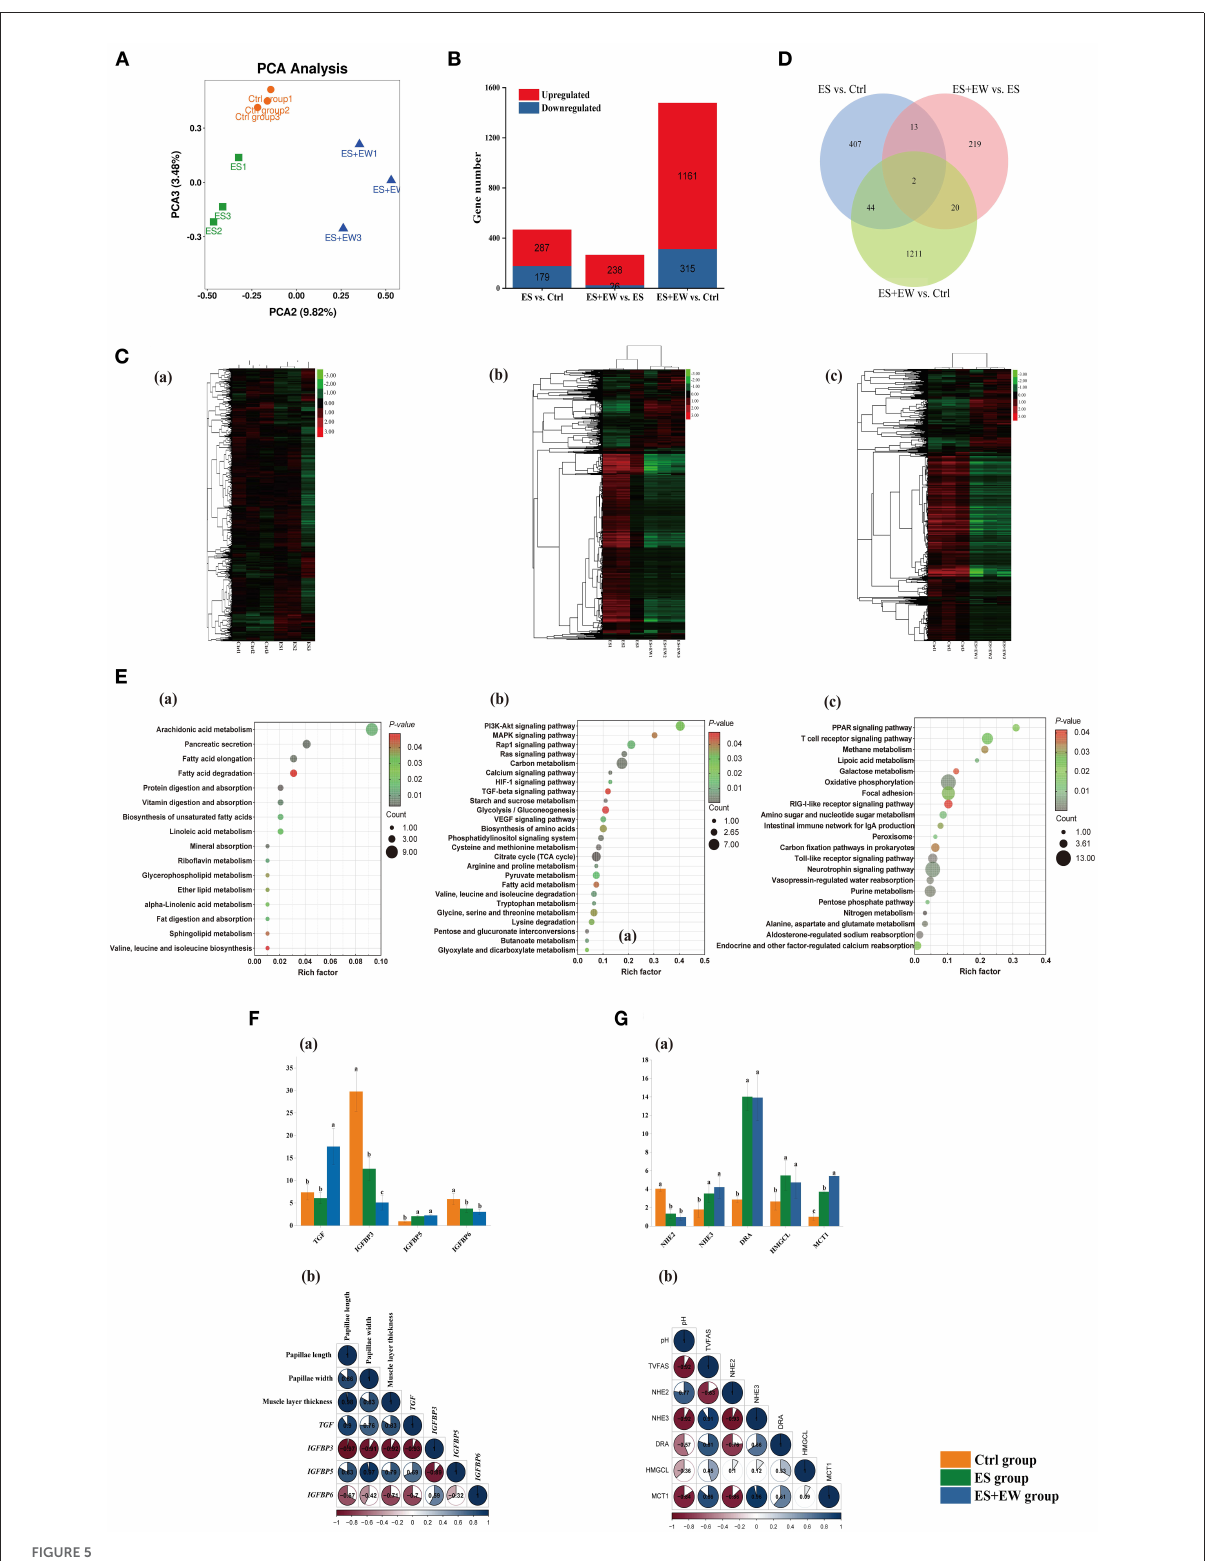
FIGURE5 The PCA analysis of gene expressions, number of DEGs, KEGG pathways, and main DEGs in the rumen tissue of lambs in different early feeding strategies at 42 days of age. (A) The PCA analysis of gene expressions in the rumen tissue among three groups. (B) The number of DEGs at each